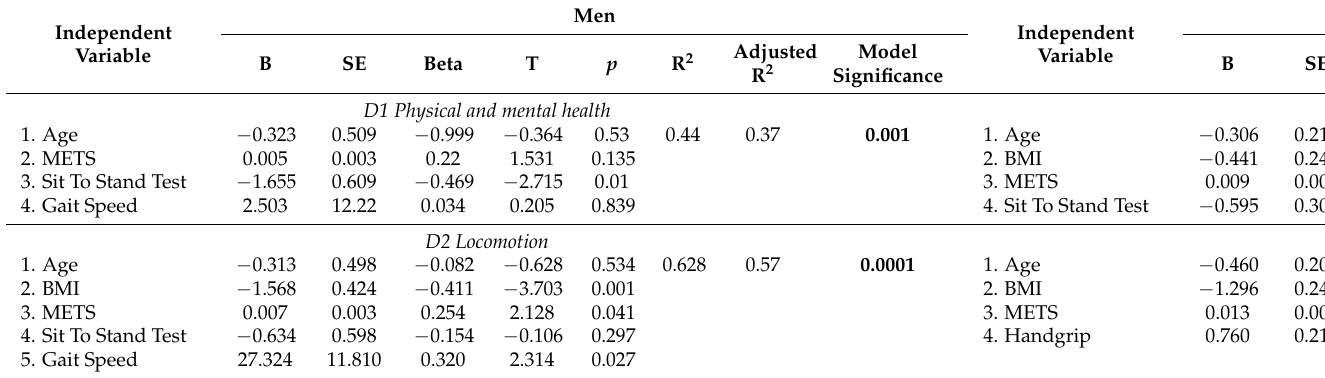
Table 3. Multiple Linear Regression Analysis with Total and Domain Scores of SarQol as Dependent